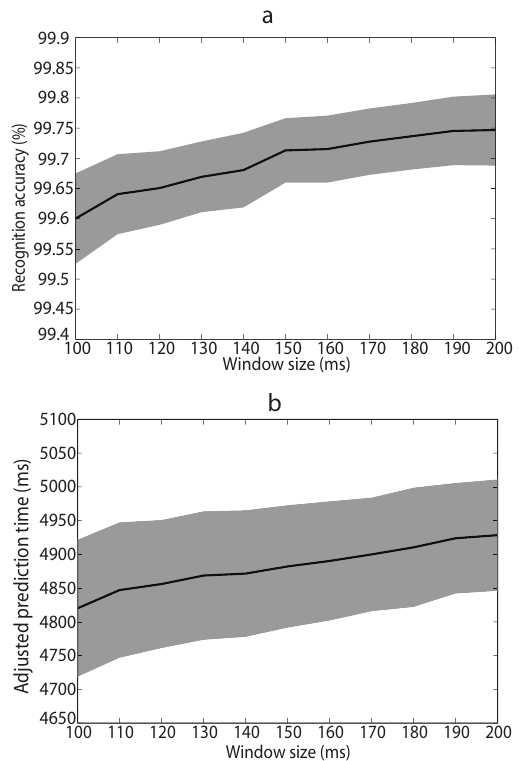
Figure 4. Average recognition accuracy ( a ) and adjusted prediction time ( b ) over seven able-bodied subjects with window size ranging from 100 ms to 200 ms. Color shades denote SEMs across